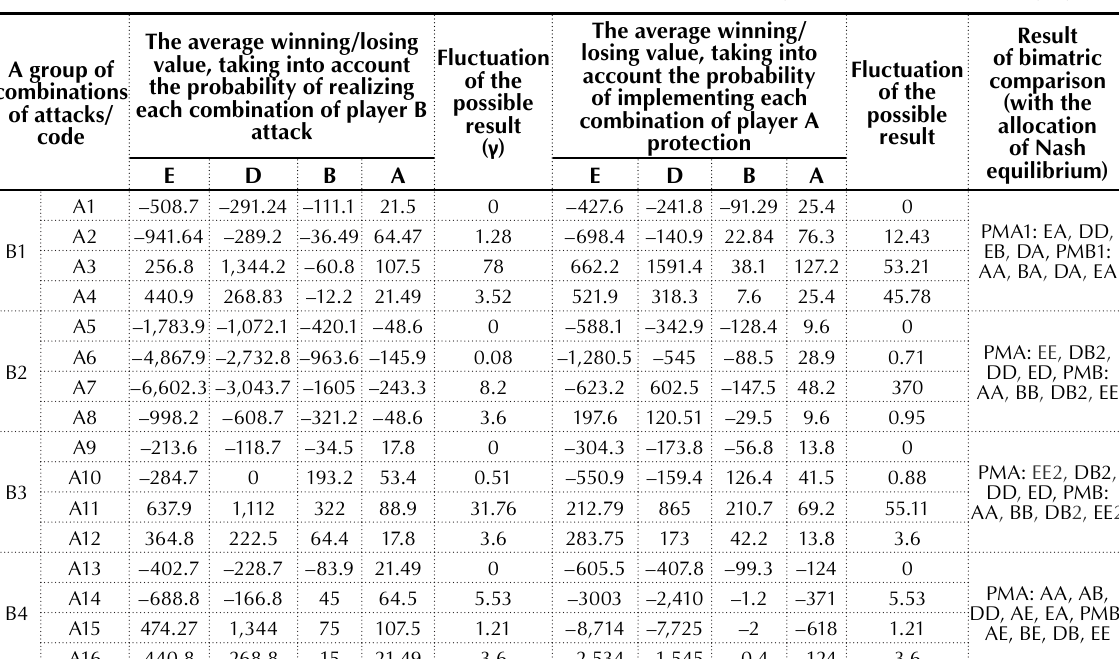
Table 2. Aggregated payment matrix of LLC “TENT TRANS” – PJSC “Transcarpathia Auto”, thousand